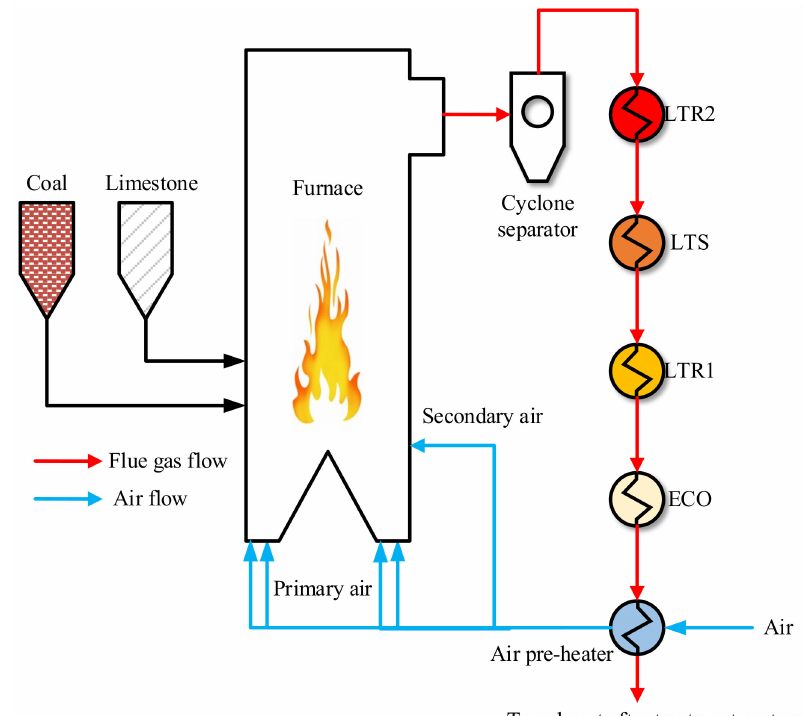
Figure 3. Diagram of the air-flue gas system.